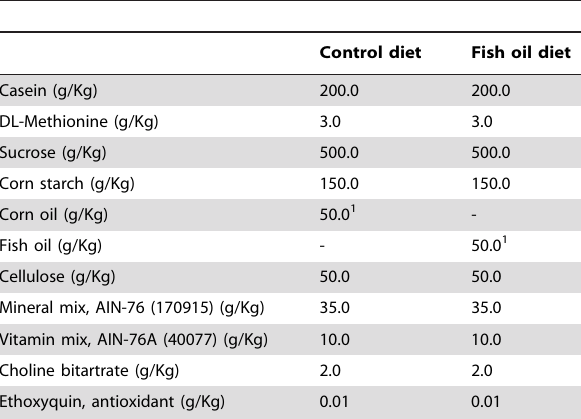
Table 1. Composition of the experimental diets used in this